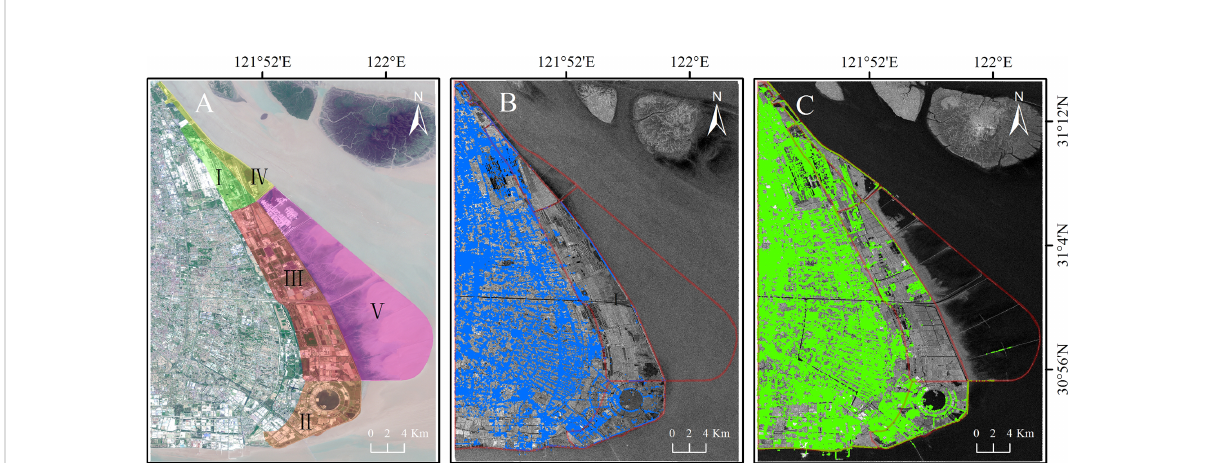
FIGURE 5 (A) The scope of the fi ve reclamation projects with the background of Sentinel-2A images acquired in 2020; (B) Distribution of PS points (marked in blue) obtained by ENVISAT/ASAR images; and (C) Distribution of PS points (marked in green) obtained by Sentinel-1A images. The